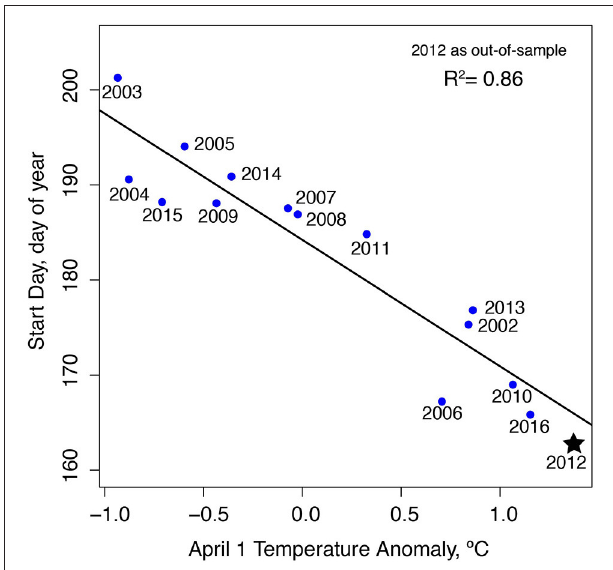
FIGURE 7 | Simple linear regression between start day and April 1 temperature anomaly. Start days from 2002 to 2016 are plotted against the April 1 (4-buoy average) temperature anomaly from the same year. Treating 2012 as an out-of-sample test, the linear regression fits well ( R 2 = 0.86) and would predict a start day of 166 (June 16). The observed start day in 2012 was 163 (June 12).